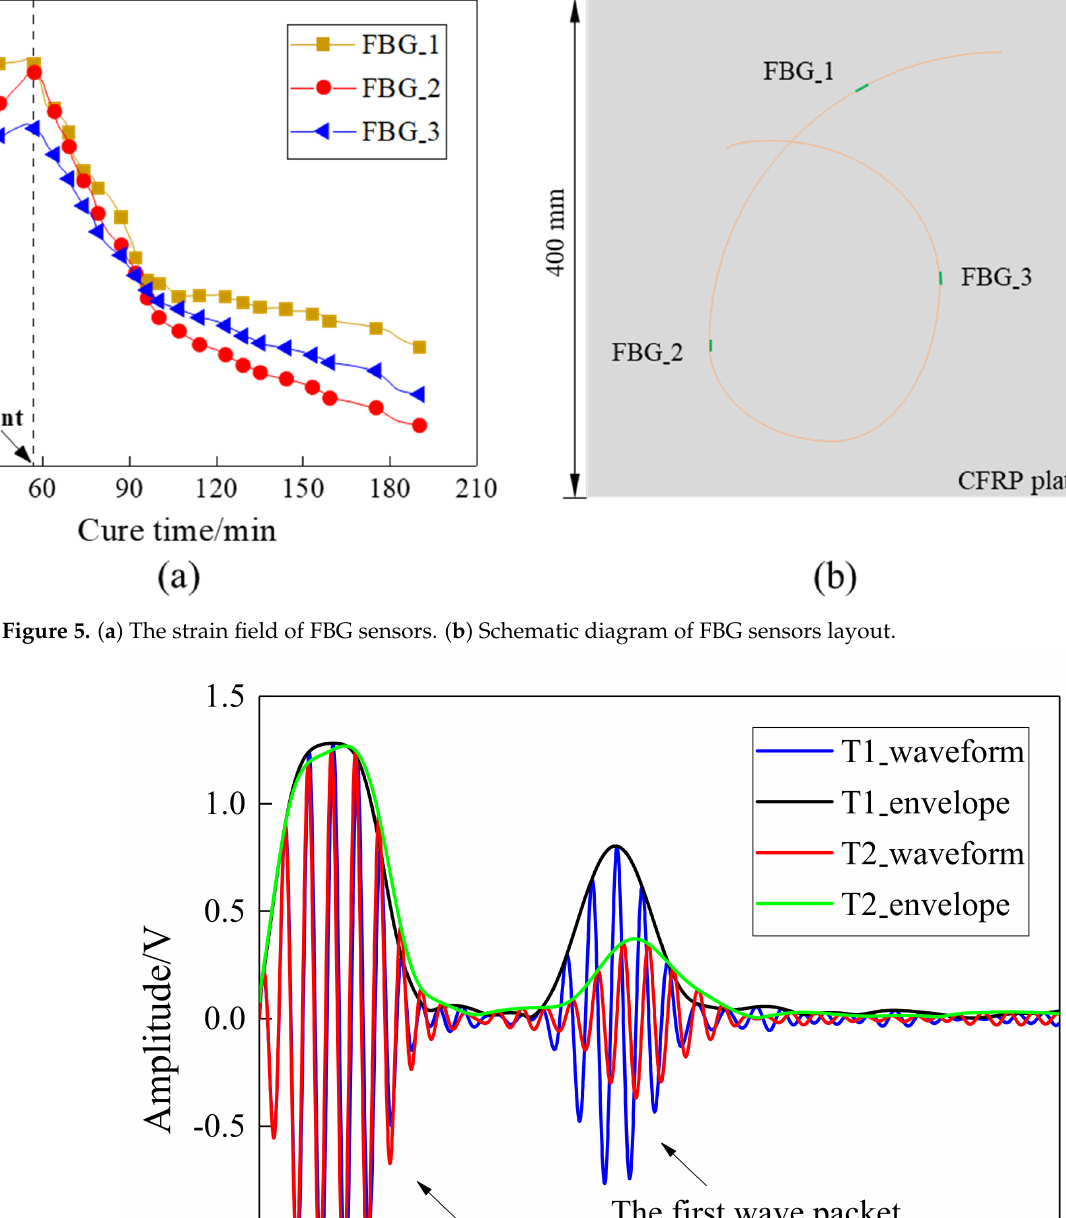
Figure 4. Recommended heating profile of the T300 prepreg provided by the manufacturer.